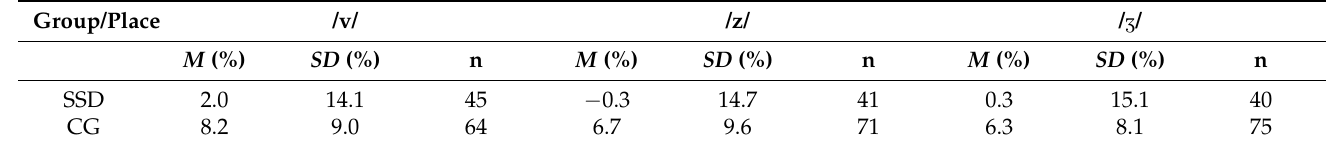
Table 4. Mean ( M ), standard deviation of the mean ( SD ) and number of samples (n) of relative f o values for the three places of articulation: /v/—labiodental; /z/—alveolar; / Z /—postalveolar.